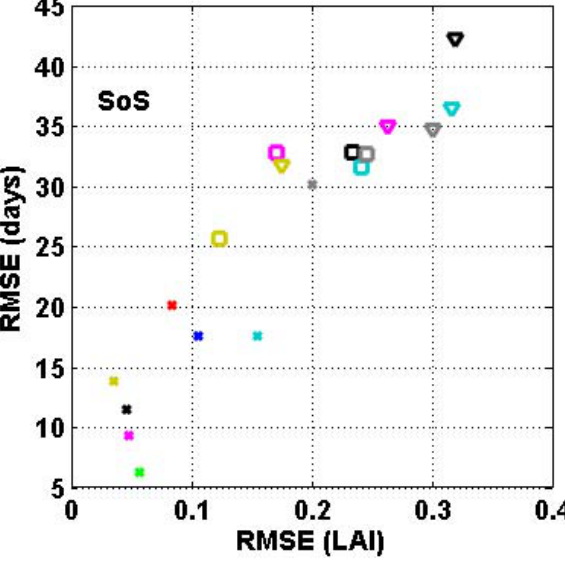
Fig. 12. Performances (distance to the origin) and slopes in the (Roughness, RMSE) feature plane (Fig. 11) associated to each method for 0% < %gap ≤ 15% ( × ), 25% < %gap ≤ 35% ( (cid:3) ) and 35% < %gap ≤ 45% ( ∇ ). Note that EMD, LPF and AGF are only displayed for the lowest %gap class. The black arrow indicates the effect of an increase of the fraction of missing data.